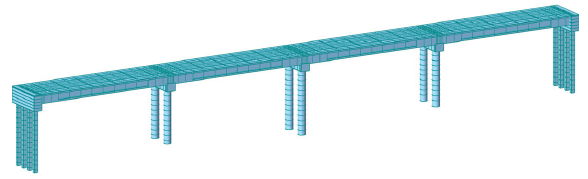
Figure 9: FEM mesh of Shangban Bridge.